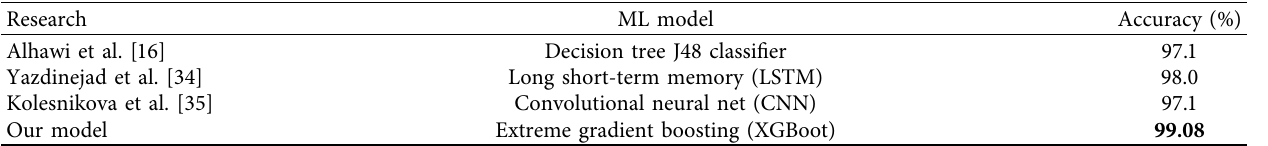
Table 6: Accuracy